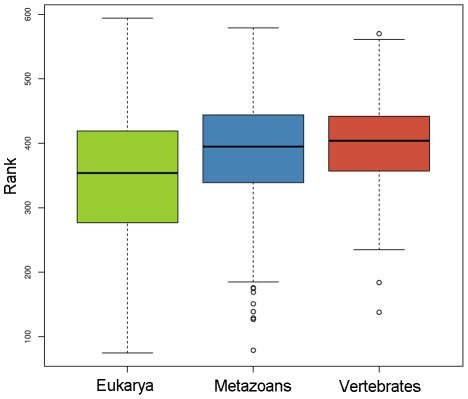
Rank of the stability score of wildtype protein sequence among 1000 mutated sequences in 3 age groups: Eukarya, Metazoans and Vertebrates.Wilcoxon tests were performed to assess the significance of the difference: Eukarya vs Metazoans: p-value<1.684e−14 , Eukarya vs Vertebrate: p-value<2.2e−16 , Metazoans vs Vertebrates: p-value = 1.119e−8). Low rank suggests that the native structure is relatively robust to mutations.